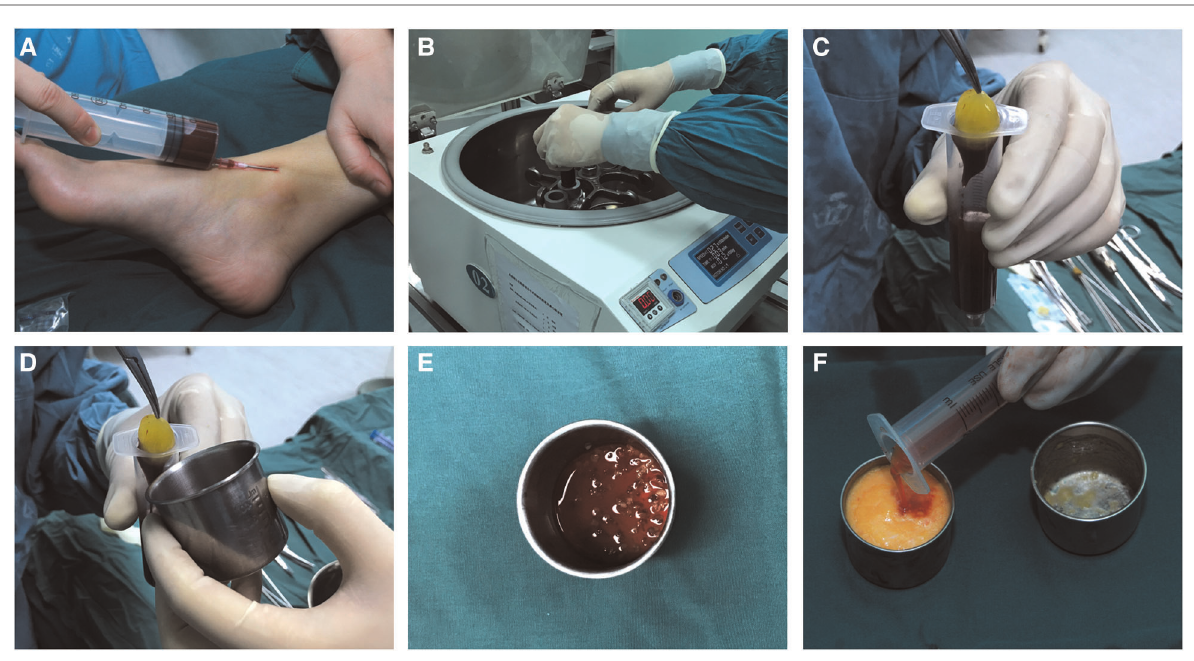
FIGURE 1 Platelet-rich fi brin preparation: ( A ) intravenous blood was collected with a disposable syringe; ( B ) the blood was centrifuged at 3000 rpm for 10 min; ( C ) a platelet-rich fi brin clot was taken out of the syringe; ( D ) platelet-rich fi brin clot; ( E ) the platelet-rich fi brin clot was cut in fragments of 1 to 2 mm; ( F ) the fragments of the PRF clot were mixed with the re fi ned fat, and the mixture was then transferred to 1 ml luer-Lok syringes for injection.